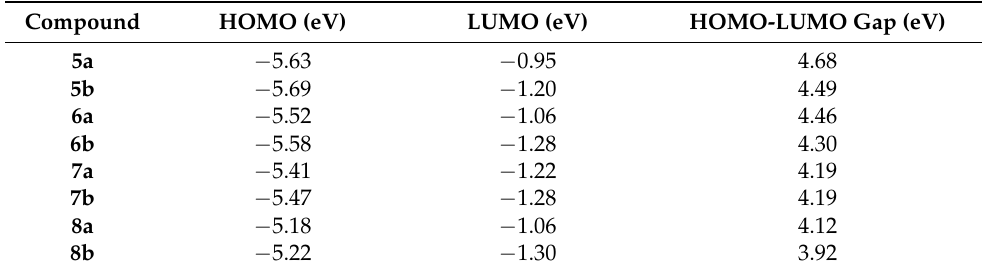
Table 8. Results of the quantum calculations.